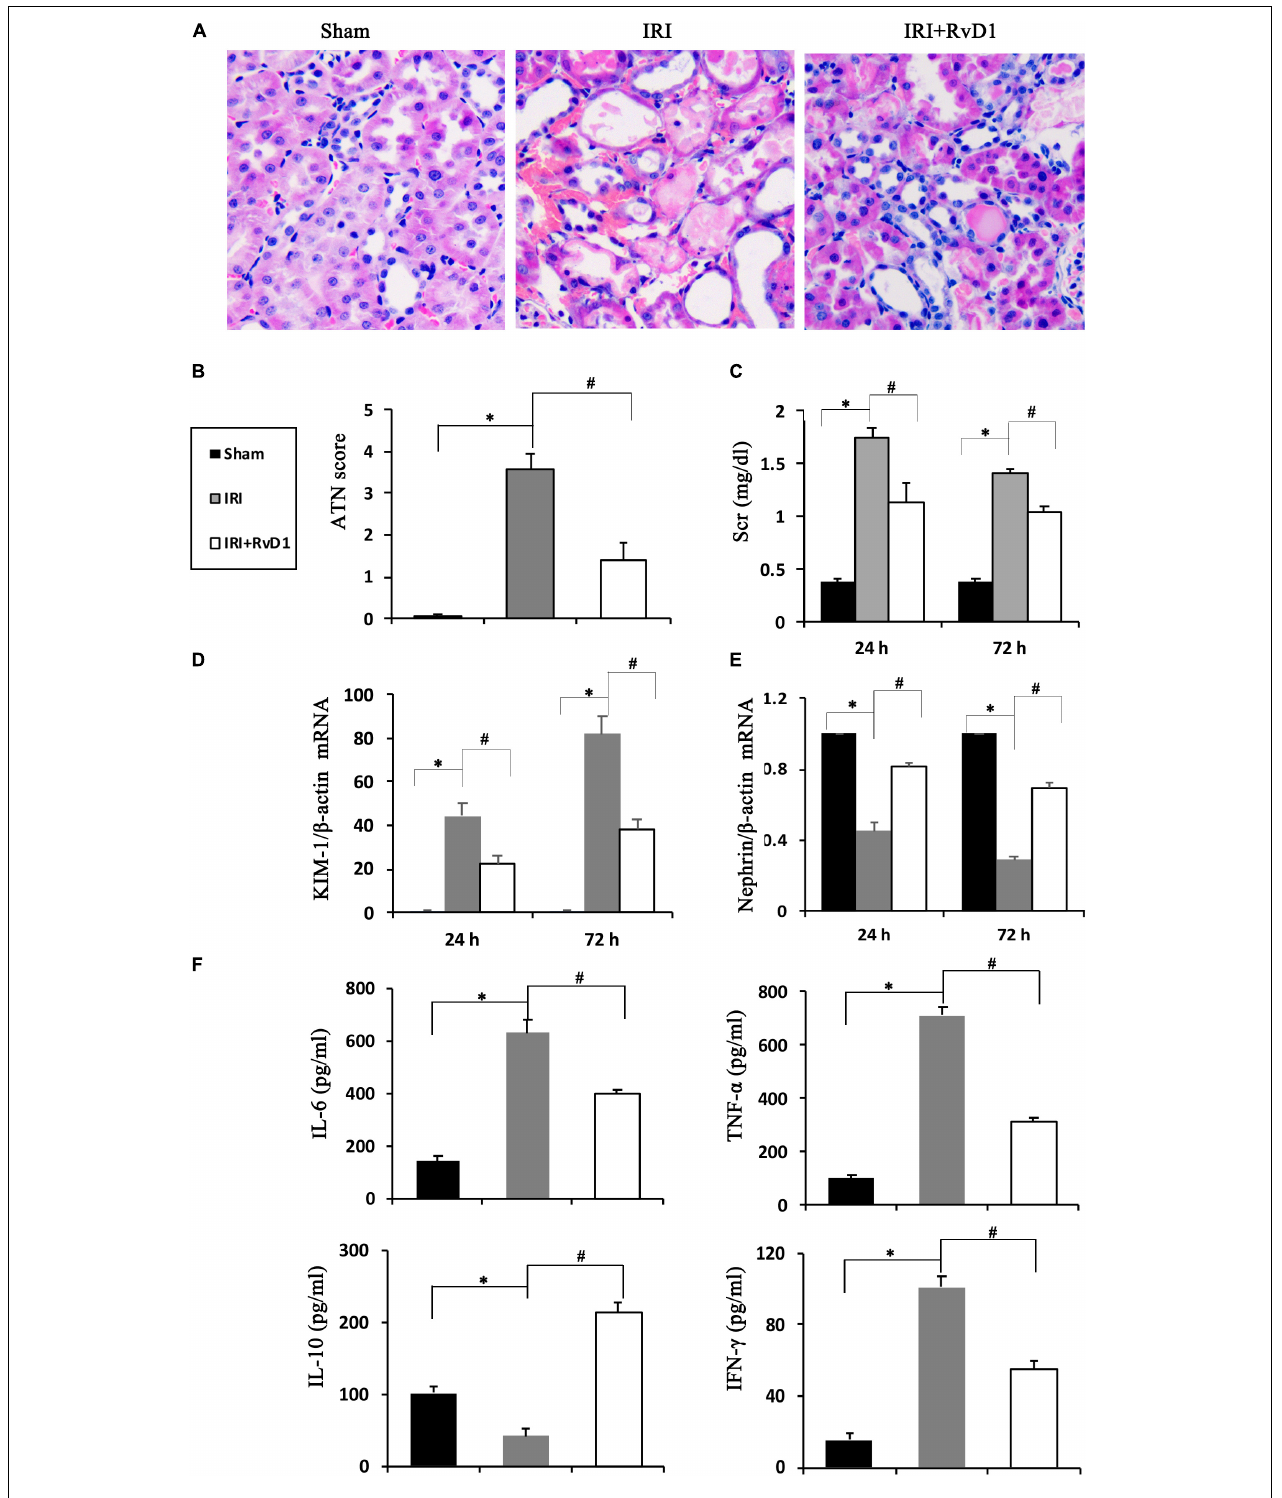
FIGURE 1 | RvD1 protected against renal injury in IRI-AKI mice. The IRI-AKI model was established by clamping the bilateral renal pedicles for 60 min. RvD1 (5 µ g/kg/d) or vehicle was administered to the mice via the tail vein at 30 min, 24 and 48 h after reperfusion. (A) Kidneys were stained by PAS (original magnification, 400 × ). (B) ATN scores at 72 h after reperfusion. (C) Serum creatinine levels at 24 and 72 h after reperfusion. The relative mRNA expression of KIM-1 (D) and Nephrin (E) at 72 h after reperfusion. (F) Serum IL-6, TNF- α , IL-10, and IFN- γ levels at 72 h after reperfusion as determined by ELISA. Values are expressed as the means ± SDs, n = 6–8 per group. ∗ P < 0.05 versus sham; # P < 0.05 versus IRI.